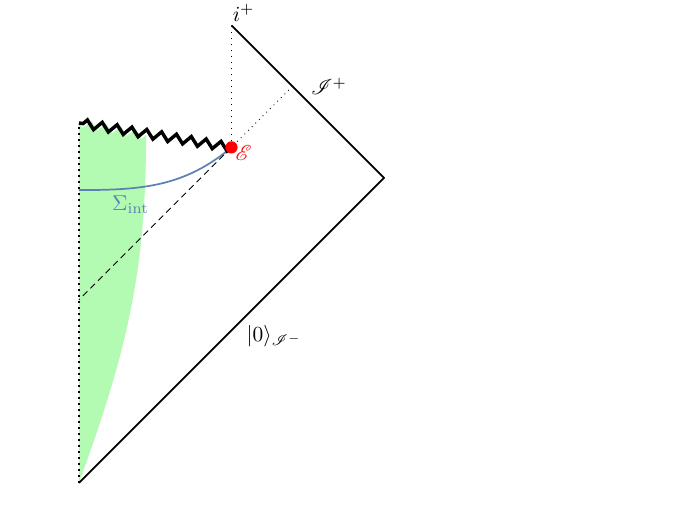
Figure 10. An extension of the spacetime of figure 8 to larger u under the PS assumption. We have a complete I + with Minkowski-like future timelike infinity i + , and may treat I + ∪ Σ int as a Cauchy surface whenever Σ int is Cauchy in the black hole